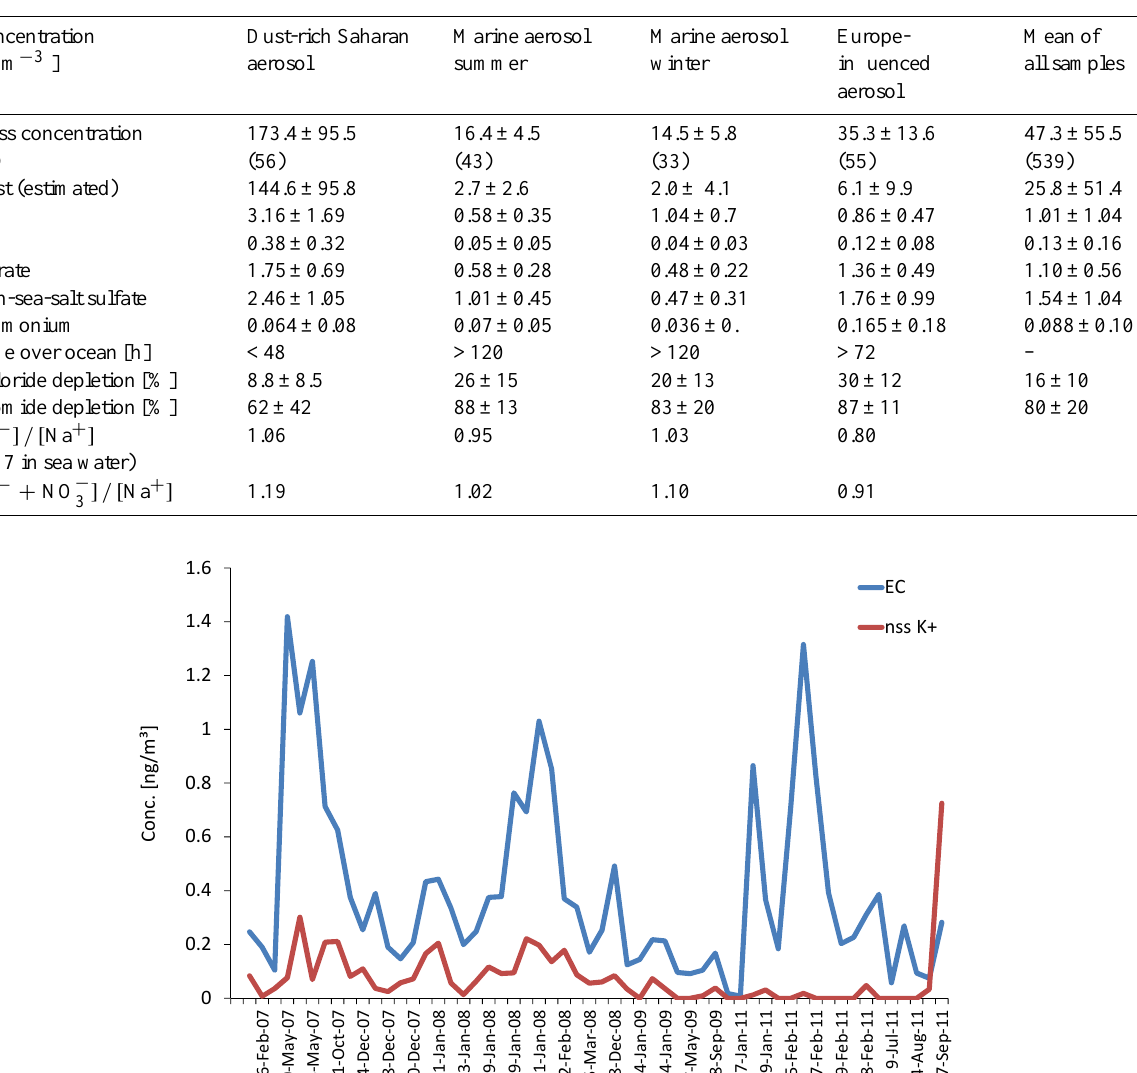
Table 5. Comparison of major non-sea-salt components and halogenide depletion (mean values and standard deviation as an estimation of the scatter) in four classes of particulate matter collected at the tower at the CVAO.